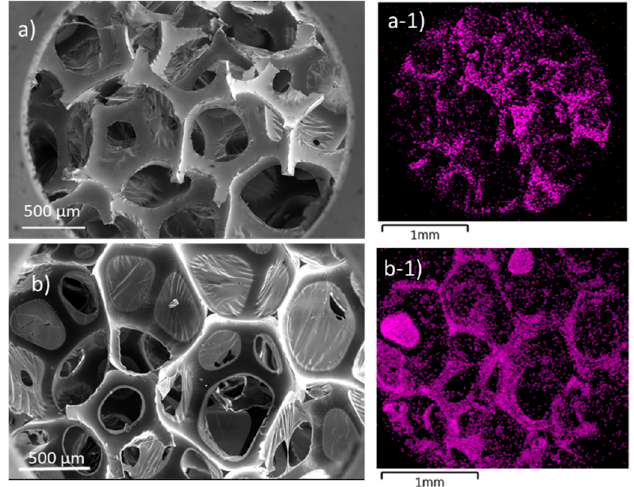
Figure 16. SEM imagines of coated PUF with 90/10 wt% of Laponite/CA-pdms-fu with different uptakes and Mapping of the Si element on coated PUF with 90/10 wt% of Laponite/CA-pdms-fu with different uptakes ( a , a-1 ) 4 wt% of load, image from the center part of PUF and ( b , b-1 ) 6 wt% of load, image from the upper edge of PUF.